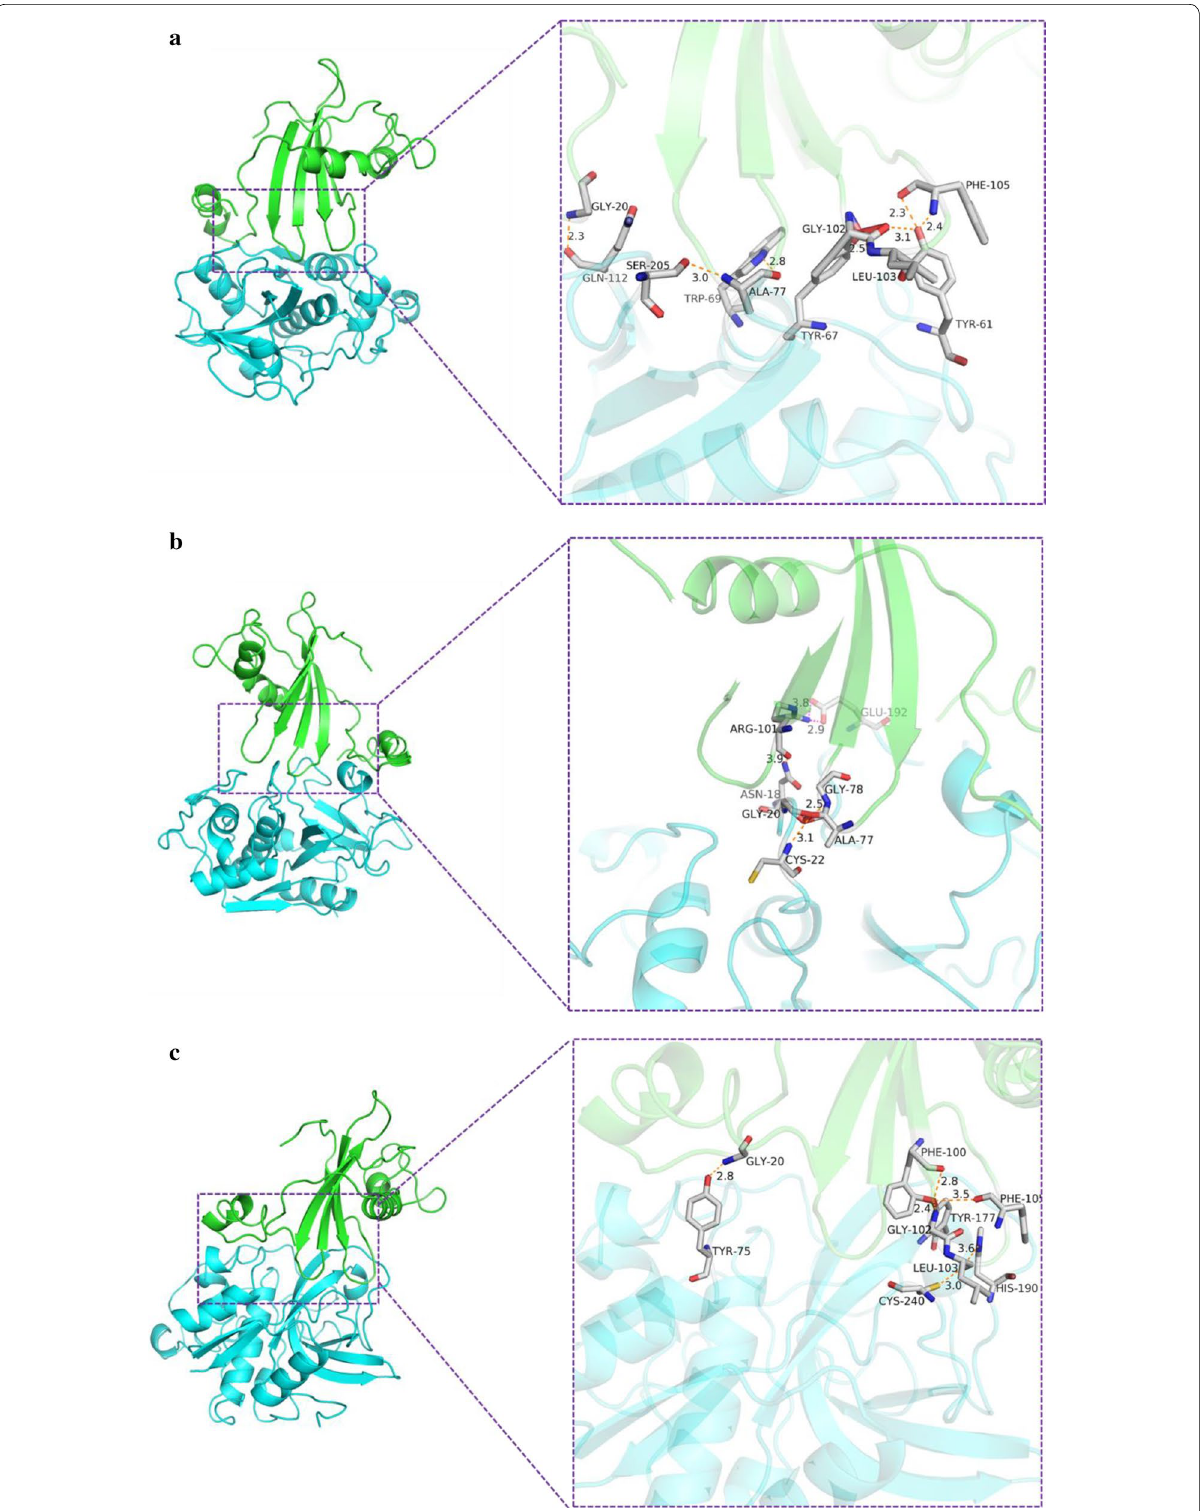
Fig. 6 Interaction between TK-cystatin and proteases. a papain (PDB ID: 1ppp), b cathepsin L (PDB ID: 2NDQ), c cathepsin B (PDB ID: 1GMY). TK-cystatin was shown in green and three cysteine proteases were shown in blue. The hydrogen and salt bonds formed between the conserved site of TK-cystatin and three proteases were shown in orange and magenta,